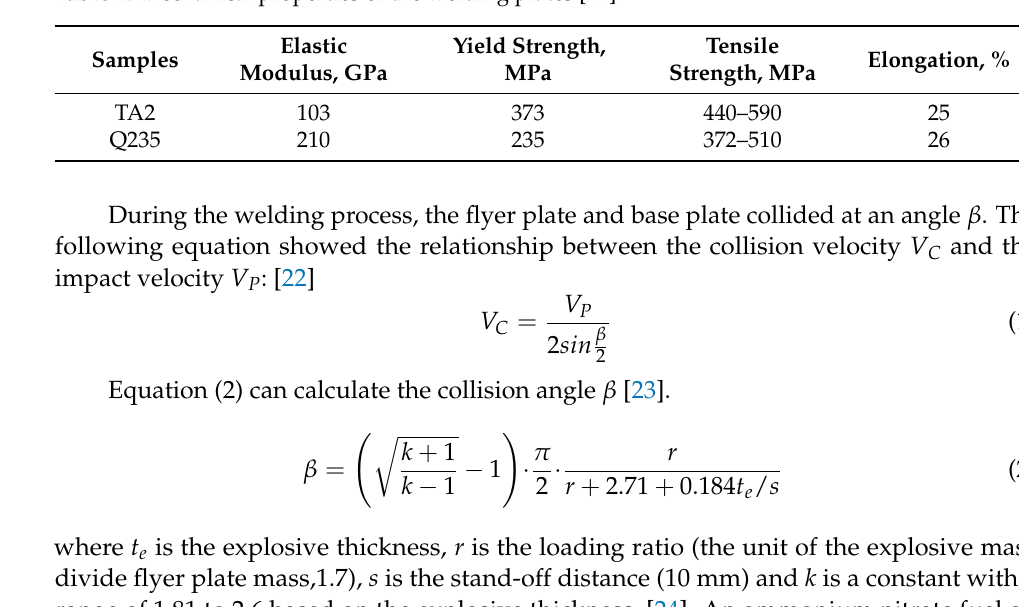
Table 2. Mechanical properties of the welding plates